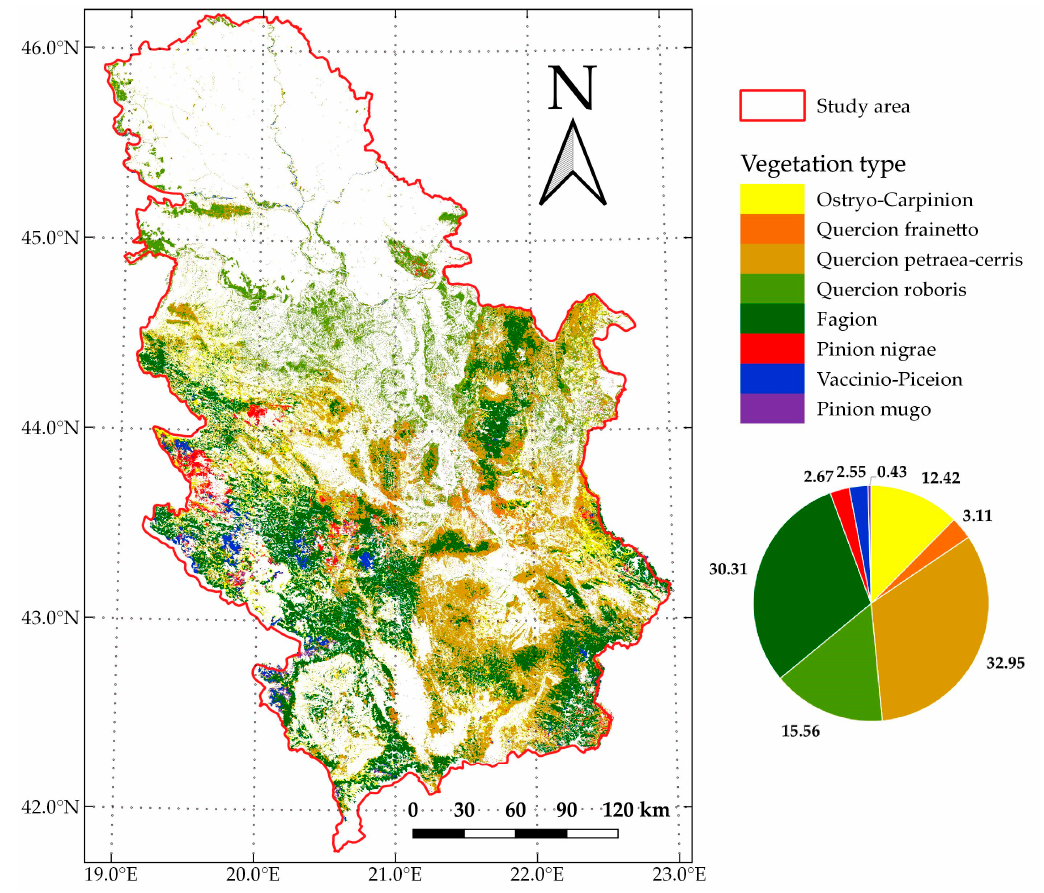
Figure 6. Final classification map of woody vegetation coverage over the study area.